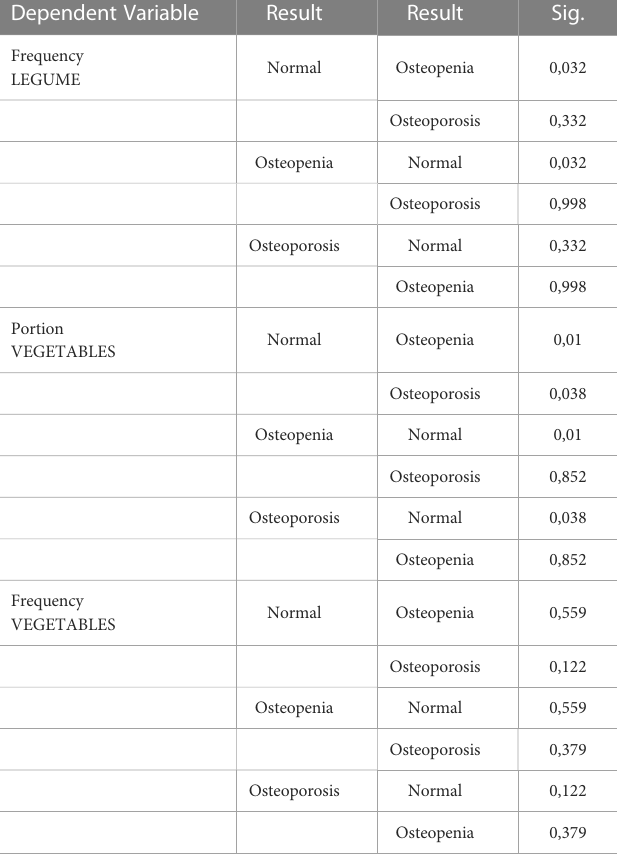
TABLE 9 ANOVA univariata,studyofthedifferencesinfoodconsumption betweensubjectswithnormalbonedensity,osteopeniceosteoporoticsubjects. Dependent